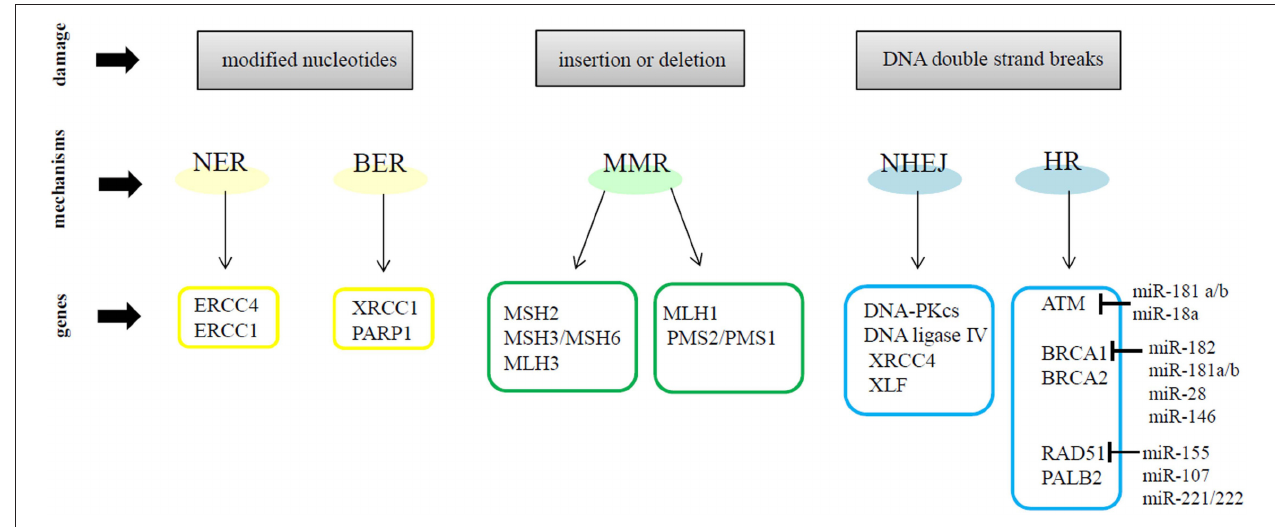
FIGURE 1 | A schematic representation of DNA repair mechanisms and some relevant miRNAs involved in the modulation of DNA repair genes.